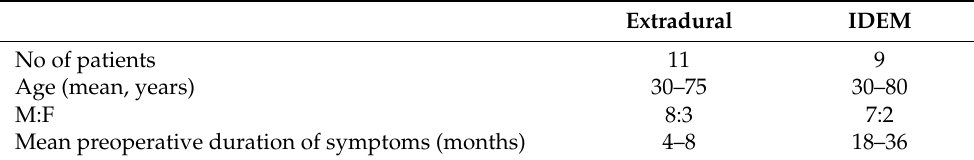
Table 1. Demographic data.